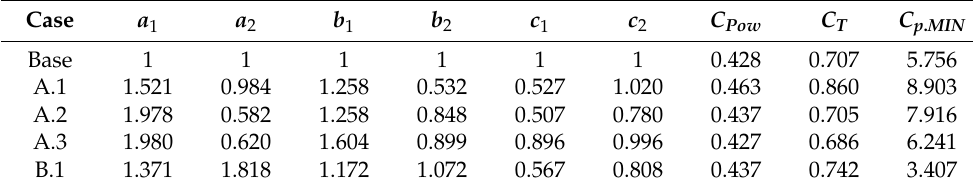
Table 2. Optimization results.